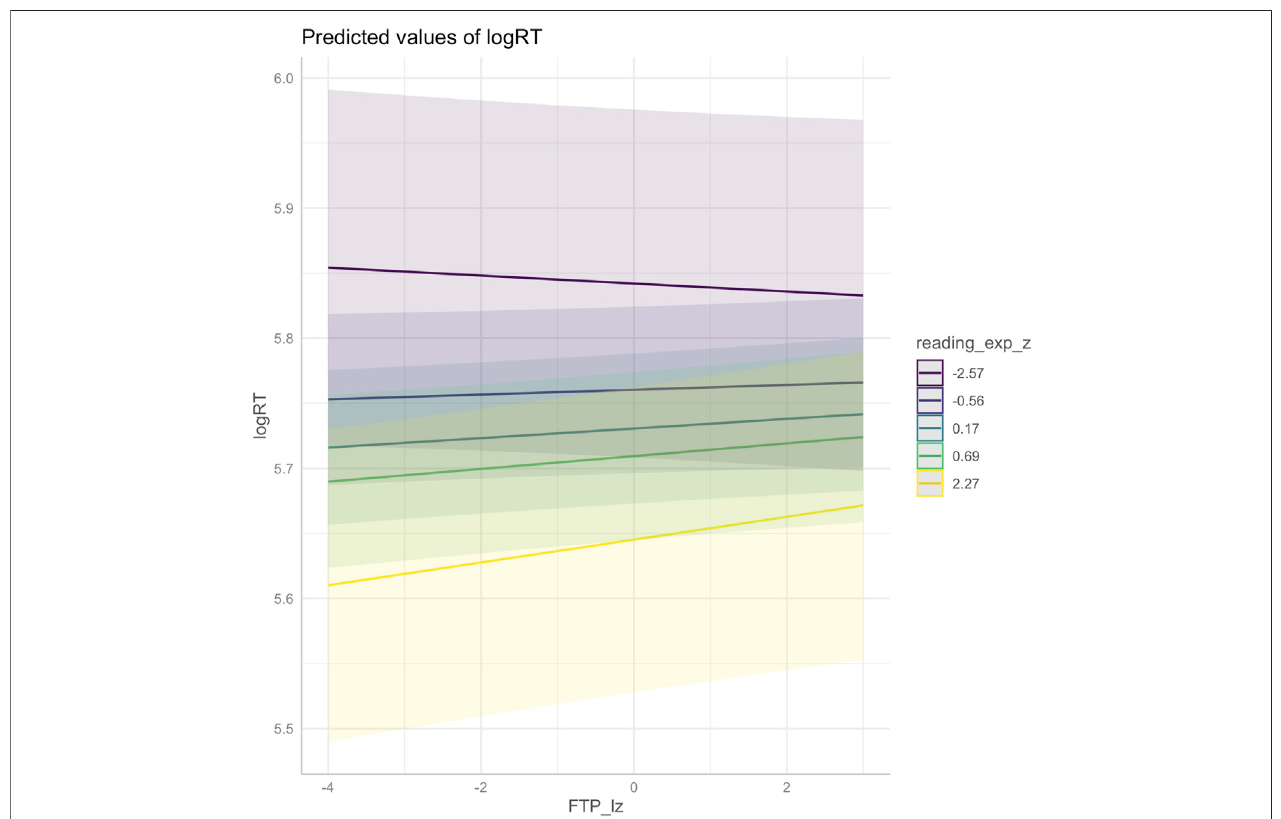
FIGURE 10 | Interaction between (log-transformed, z-scored) forward transition probability and reading experience (at the minimum, fi rst quartile, median, third quartile, and maximum values).